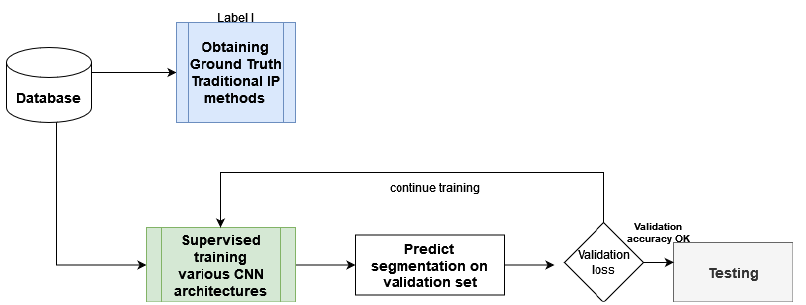
Figure 13. Training process of a single